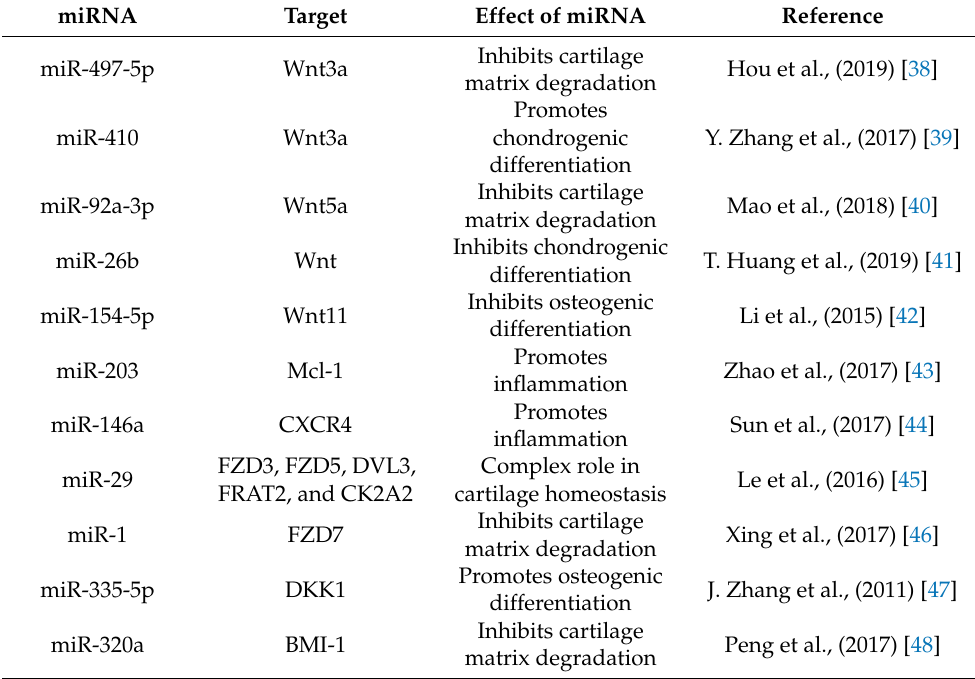
Table 1. miRNAs targeting Wnt ligands/receptors and associated proteins in the pathogenesis of OA.